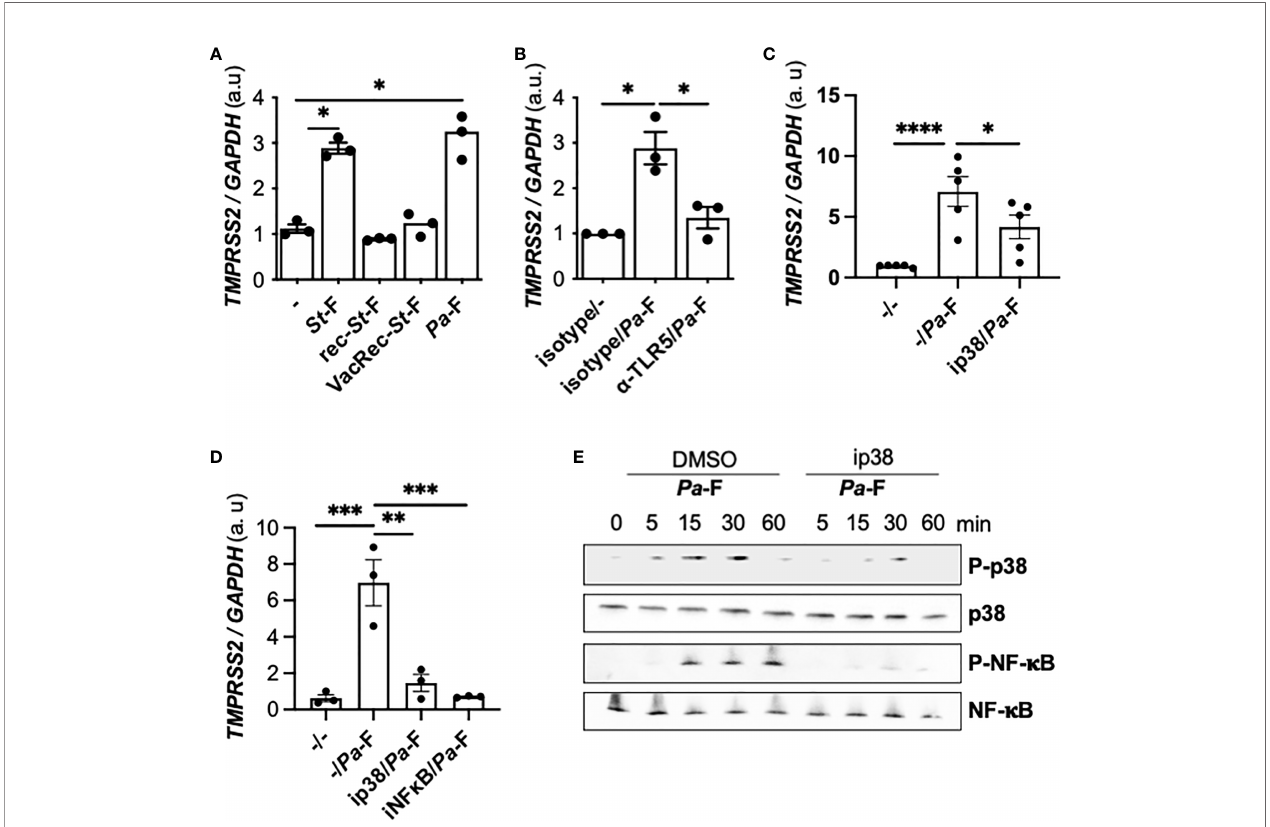
FIGURE 3 | Effect of TLR5 and p38 inhibition on fl agellin induced-TMPRSS2 expression in CFTR -de fi cient cells. (A) TMPRSS2 mRNA expression in Calu-3- CFTR -KD grown at the air-liquid interface and either not stimulated or stimulated for 6 h with 50 ng/mL ultrapure fl agellin from S. Typhimurium ( St )-F, recombinant St -F, vaccigrade St - F , or Pa -F ( n = 3, ANOVA with Dunnett ’ s multiple-comparison test, * P < 0.05). (B) TMPRSS2 mRNA expression in Calu-3- CFTR -KD cells grown at the air-liquid interface and incubated for 1 h with isotype control (reference) or anti-TLR5 antibody (10 m g/mL) and then either not stimulated or stimulated for 6 h with Pa -F (50 ng/mL) ( n = 3, ANOVA with Dunnett ’ s multiple-comparison test, control group: Isotype/ Pa -F, * P < 0.05). TMPRSS2 mRNA expression in Calu-3- CFTR -KD cells grown at the air-liquid interface (C) or in primary CF hAECs (D) that were preincubated for 1 h with 20 m mol/L p38 or 20 m mol/L NF- k B inhibitors and then stimulated for 6 h with 50 ng/mL Pa -F in the presence of the inhibitor. ANOVA with Dunnett ’ s multiple-comparison test, control group: -/ Pa -F, * P < 0.05, ** P < 0.01, *** P < 0.001, **** P < 0.0001. (E) Western blot (with 10 m g of protein) of phospho- and total p38 and phospho- and total NF- k B in primary hAECs stimulated with 50 ng/mL Pa